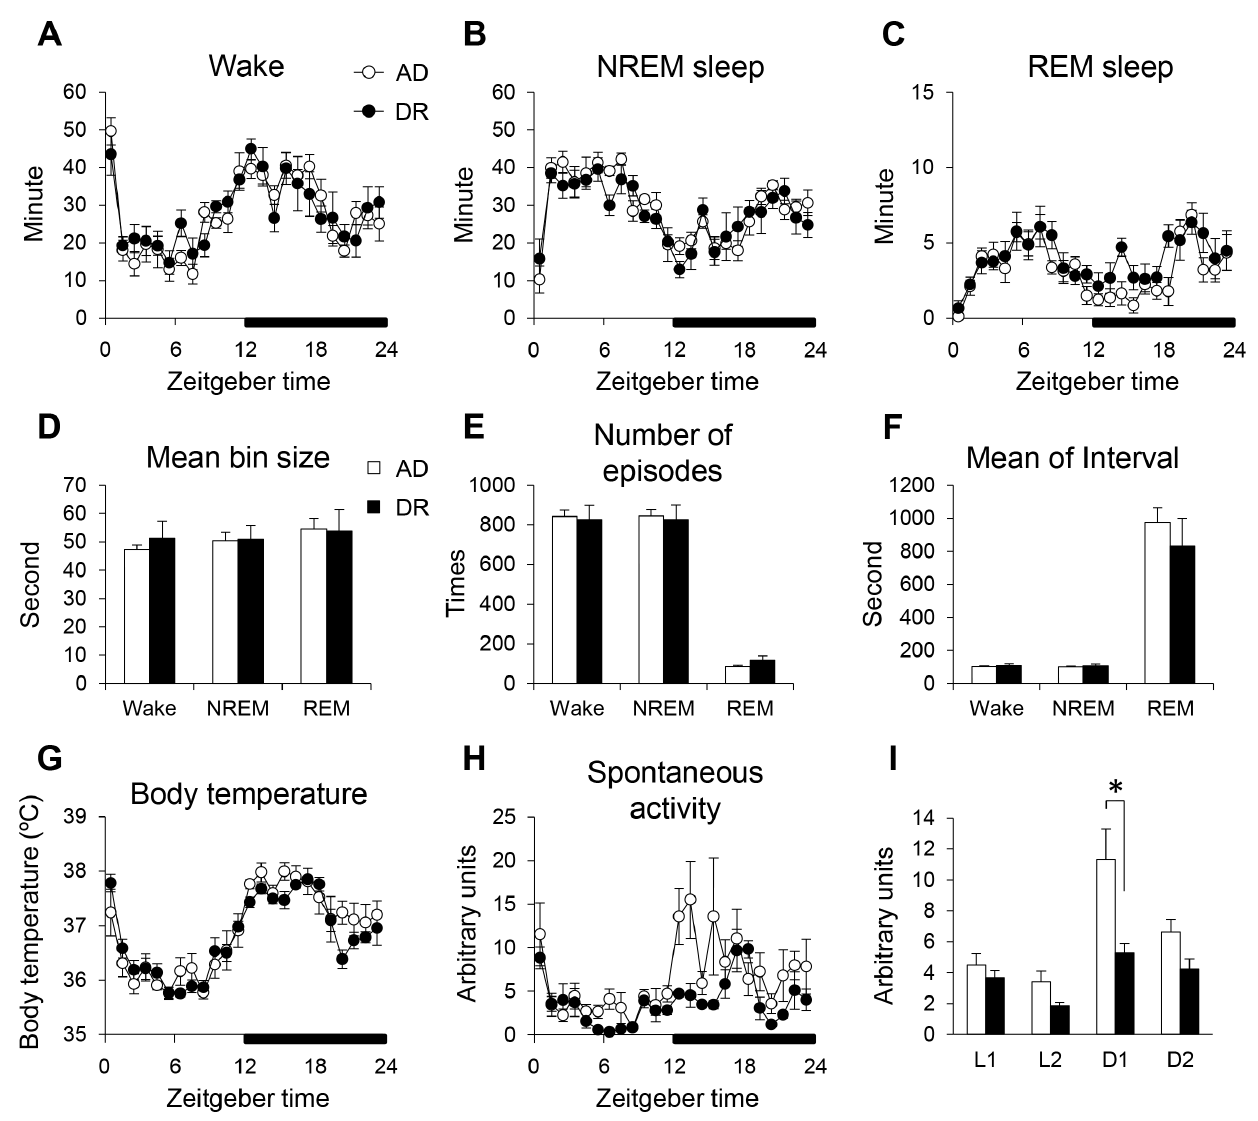
Figure 2. The influence of dietary restriction during gestation on sleep/wake architecture, body temperature, and spontaneous activity in adult offspring mice. Diurnal changes of wakefulness (A), NREM sleep (B), and REM sleep (C). Mean bin size (D), number of episodes (E), and mean interval (F) in each sleep/wake state for all 24-hour recordings. Hourly time course of body temperature (G) and spontaneous activity (H). Spontaneous activity was averaged for each 6-hour period (I) across ZT0-6 (L1), ZT6-12 (L2), ZT12-18 (D1), and ZT18-24 (D2). Open bars and circles indicate AD mice. Closed bars and circles indicate DR mice. Data represent means 6 SEM (A–F; n=6, G–I; n=5). *p , 0.05 indicates a significant difference. pressure. The procedure of shaking and latency measurement was performed 5 times and the latency was averaged for each mouse.